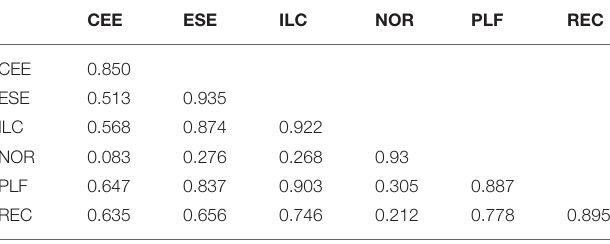
TABLE 5 | Correlation matrix.